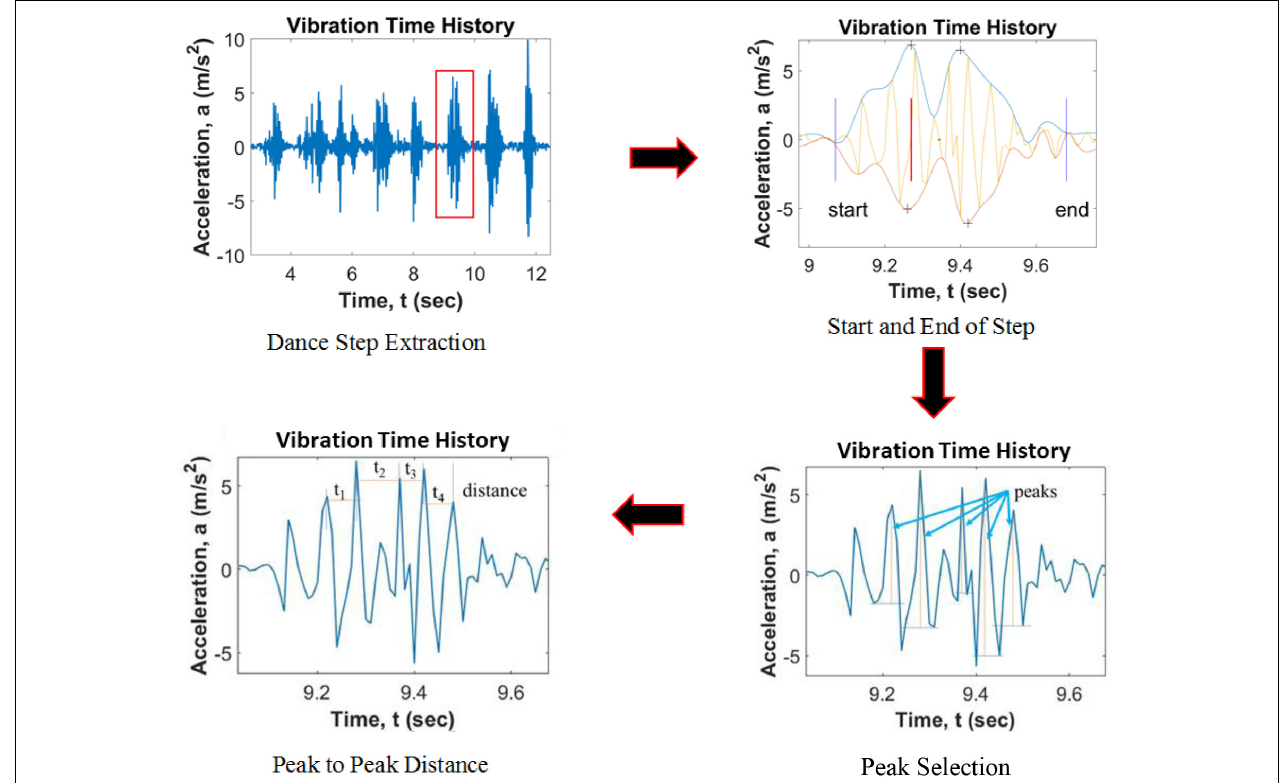
FIGURE 5 | Harmony Index